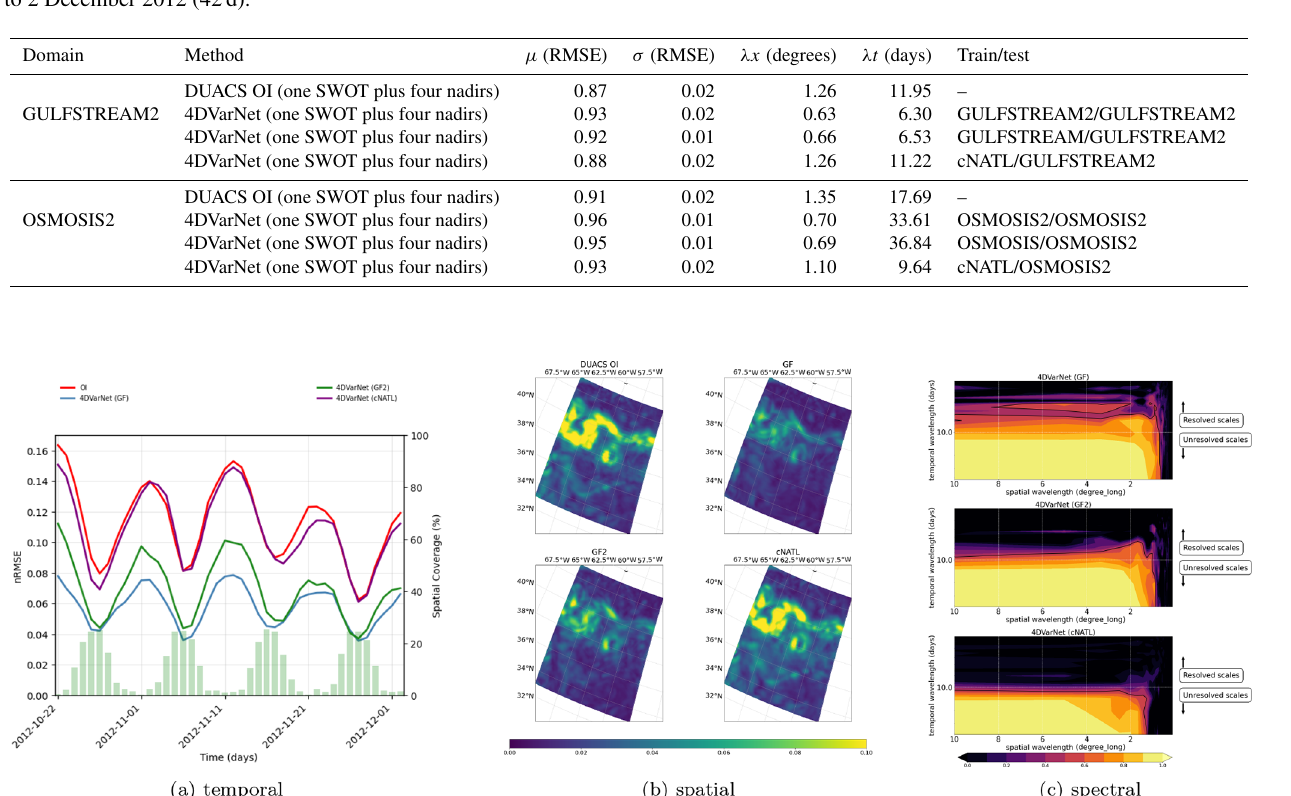
Table B1. 4DVarNet performance on the GULFSTREAM2 and OSMOSIS2 domain compared to DUACS OI over the period from 22 October to 2 December 2012 (42d).